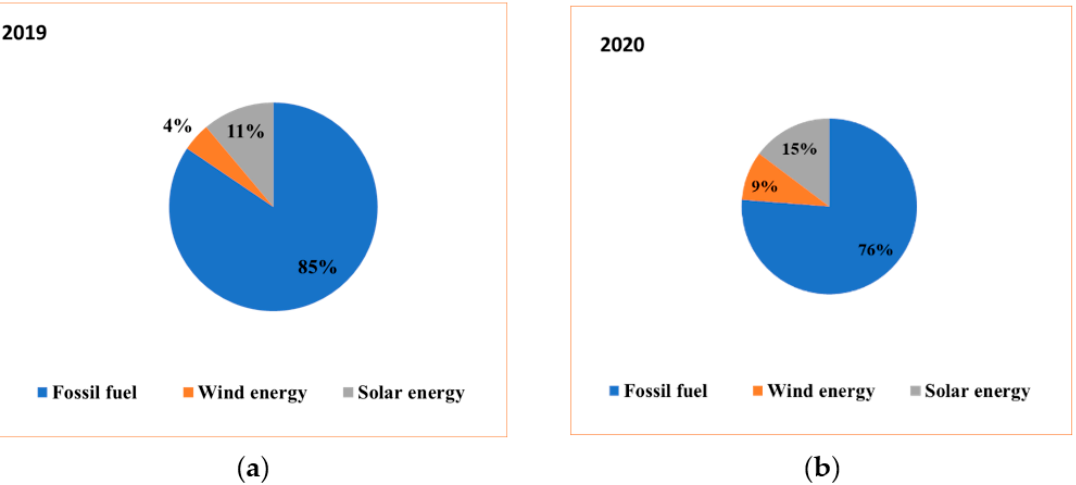
Figure 22. Contribution of fossil foil and renewable energy in electricity generation. ( a ) 2019, ( b )